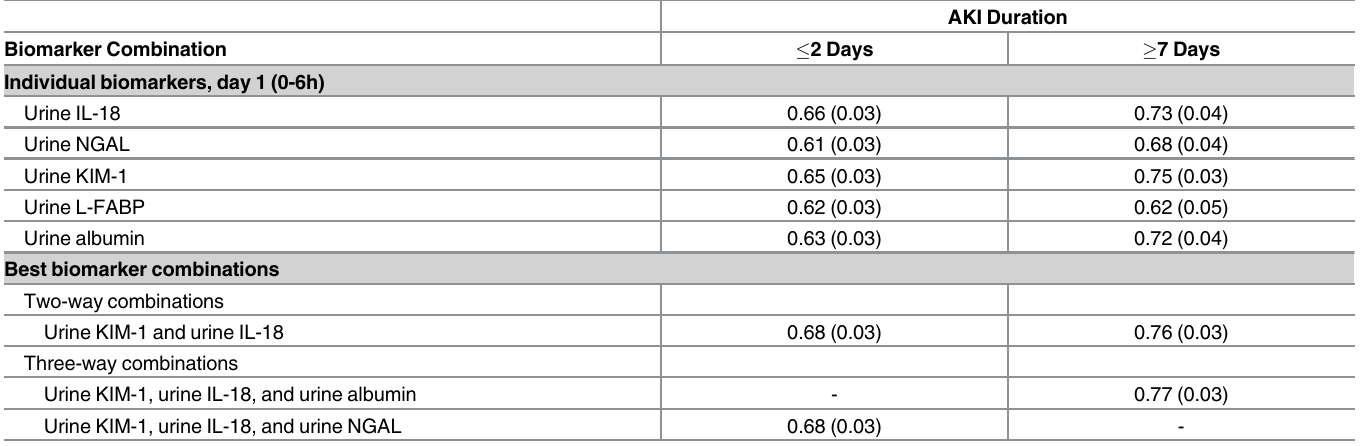
Table 4. AUC using biomarker levels at 0 – 6 hours for the outcome of AKI duration.